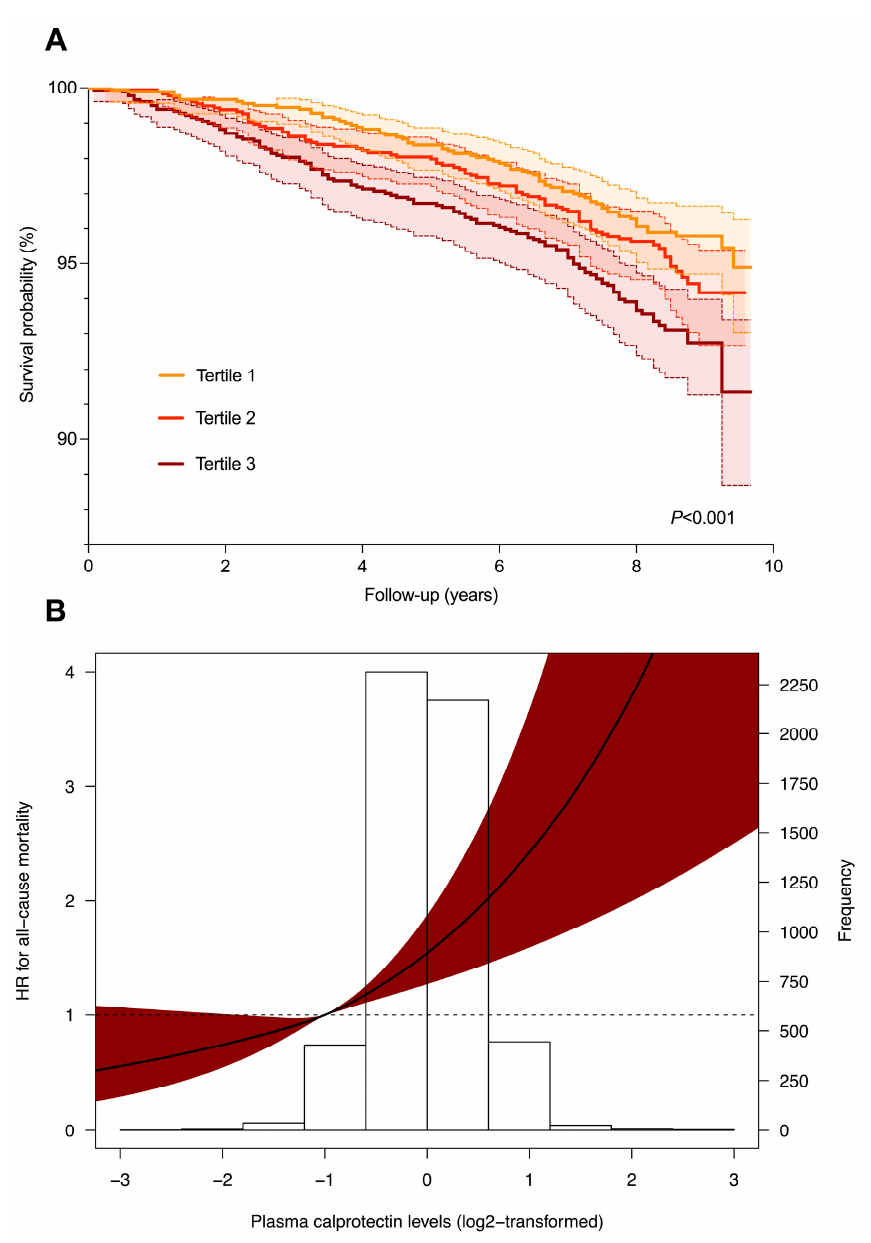
Figure 2. Plasma calprotectin levels are associated with the risk of all-cause mortality in the general population. ( A ) Kaplan–Meier survival curves for tertiles of plasma calprotectin levels, showing survival distributions with 95% confidence intervals based on the outcome of all-cause mortality. The highest rate of all-cause mortality was observed in the highest tertile of plasma calprotectin levels (log-rank test, p < 0.001). ( B ) Restricted cubic spline (RCS) regression demonstrating the relationship between plasma calprotectin levels and the risk of all-cause mortality. Estimates were derived from the Cox proportional hazards regression model, while RCS was based on three knots set at the 10th, 50th, and 90th percentiles. A likelihood ratio test for nonlinearity was not statistically significant ( p = 0.519). The dark-red-shaded area represents the 95% confidence interval. Abbreviations: HR, hazards ratio.